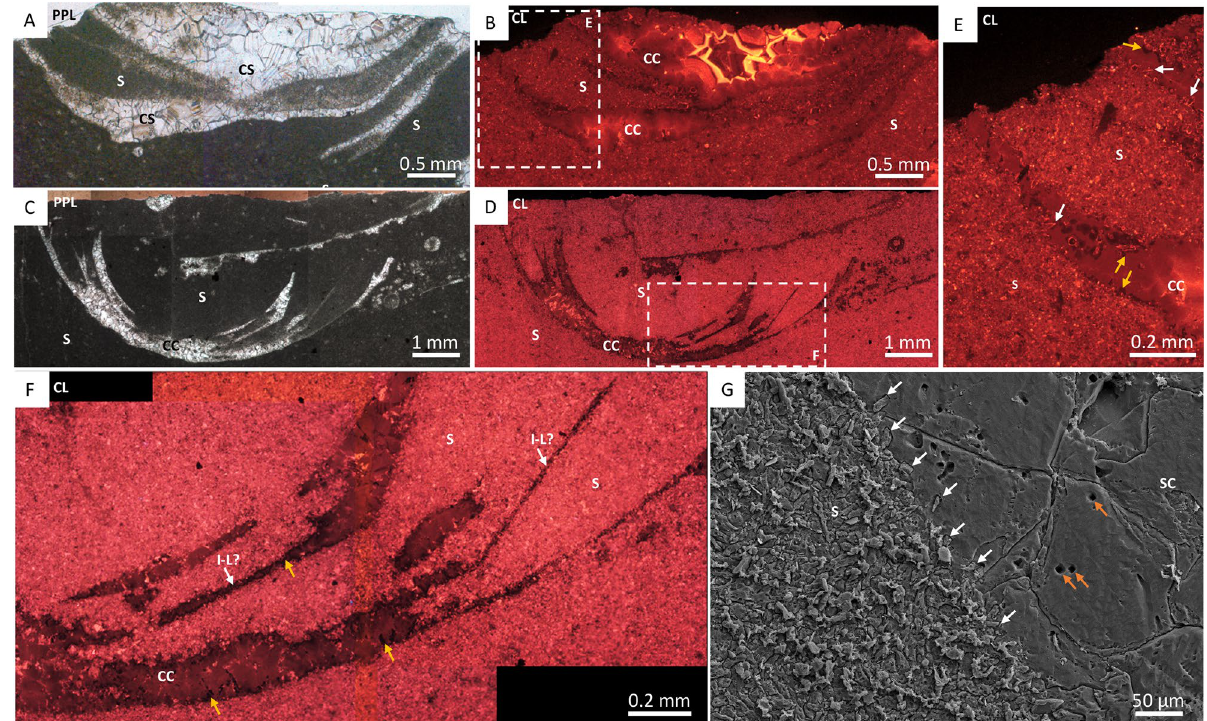
Figure 6. Photomicrographs of Cloudina from Zwartmodder, Upper Omkyk Member, Nama Group. ( A ) PPL of compacted Cloudina skeleton (CS) surrounded by dolomitised micritic sediment (S). ( B ) CL of A, featuring dull cement which becomes well-zoned with bright luminescence during later growth. The cement infill is centripetal cement (CC) which nucleates from the wall and grows into the mould formed through dissolution. ( C ) PPL of broken and spalled laminae. ( D ) CL of C, the skeletal tube consists of a dull luminescent CC, which in thicker areas is brightly luminescent. Dolomitised micritic sediment surrounds the `spalling’ skeleton. ( E ) Inset of B, brightly luminescent cement nucleates from sediment grains, which protrude into the Cloudina mould (white arrows) and are overgrown by a non-luminescent cement (yellow arrows) that formed before CC. ( F ) Inset of D, sediment infills areas between spalling potential inter-laminae (I-L?), spalling occurs where CC has not formed between the laminae. Bright luminescent cements on micritic sediment grains which protrude into the Cloudina mould which is overgrown by a non-luminescent cement (yellow arrows). ( G ) Sparry calcite (SC) infill of the Cloudina skeleton, where cement crystals protrude from surrounding sediment (white arrows). Cube-shaped holes in the SC may represent plucked micro-dolomite or pyrite crystals. Figure created in PowerPoint